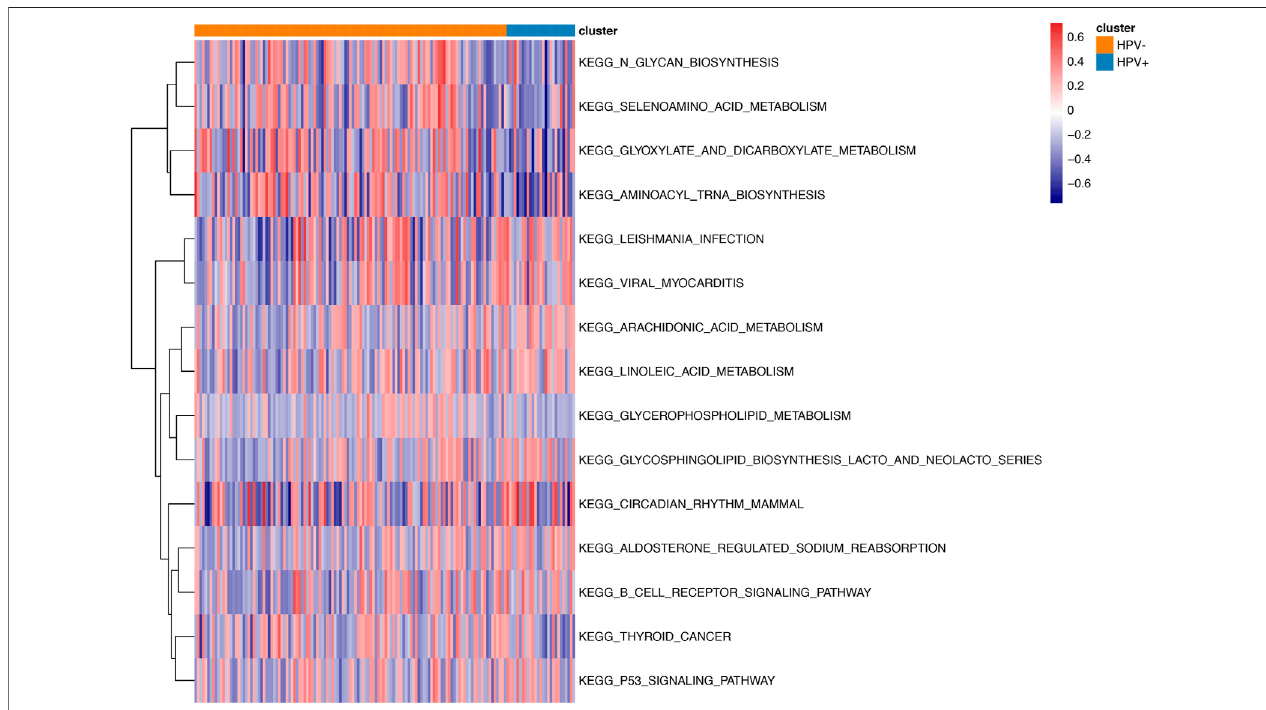
FIGURE2 | GSVA enrichment analysis between HPV positive and negative samples. Different colors stand for different status of biological pathway: red means activation and blue means